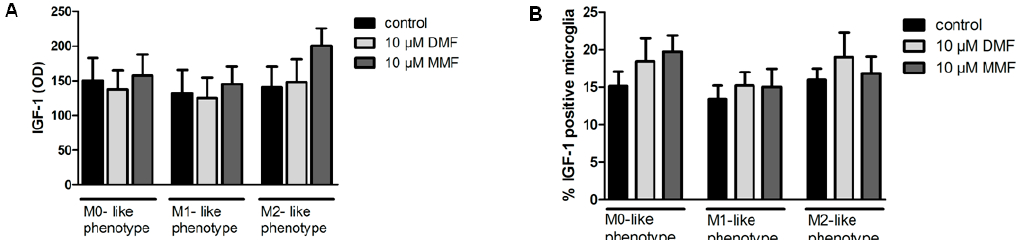
Figure 3. Effects of DMF and MMF on IGF-1 expression. Secretion of IGF-1 protein by microglia was assessed by ELISA. Microglia were treated with medium, 10 µM DMF or 10 µM MMF for 24 h and stimulated with LPS or IL-4 for 6 h. Cell culture supernatants were analyzed for IGF-1 secretion by ELISA ( A ). Cell pellets of the same experimental setting were analyzed for IGF-1 production with FACS analysis ( B ) Data are presented as the arithmetic means ± SEM of n = 4.